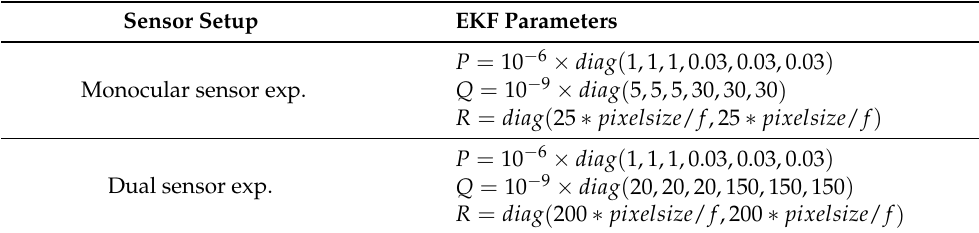
Table A1. EKF parameters used in the different experiments. diag means a square matrix where all non-zero-values are on the diagonal and presented in a vector form. Sensor Setup EKF Parameters Monocular sensor exp.